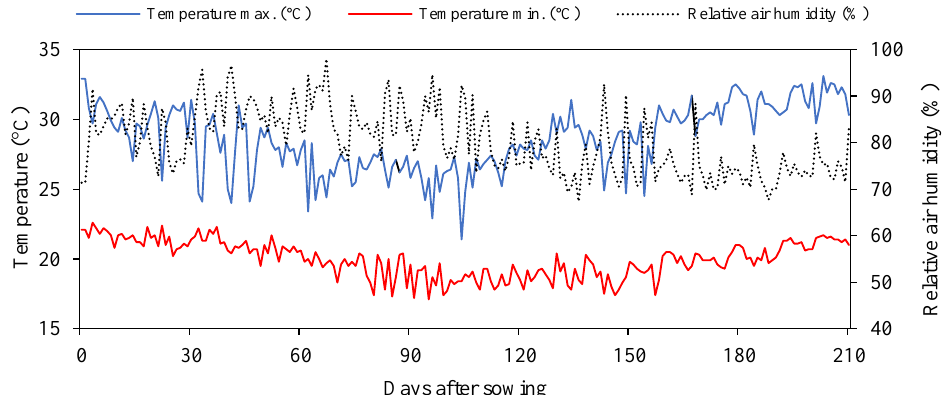
Figure 5. Observed daily temperature (maximum and minimum) and average relative humidity of air in the internal area of the greenhouse during the experimental period.